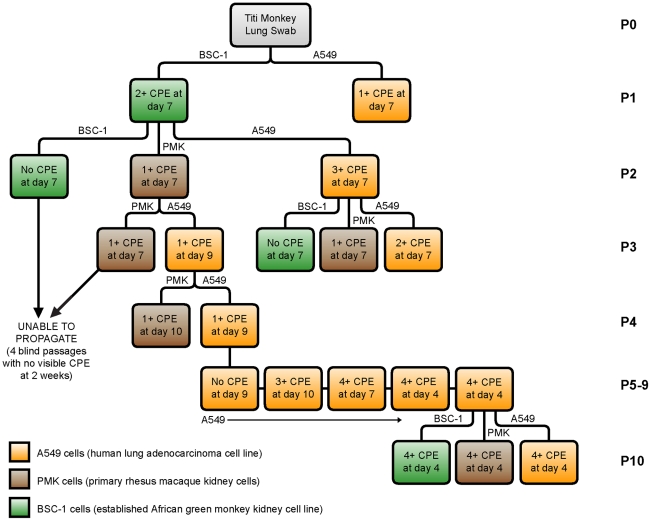
Growth and propagation of TMAdV in cell culture.The flow chart displays 10 passages (P1–P10) of TMAdV cultured in human lung adenocarcinoma (A549, orange), primary rhesus macaque kidney (PMK, brown), or established African green monkey kidney (BSC-1, green) cells.